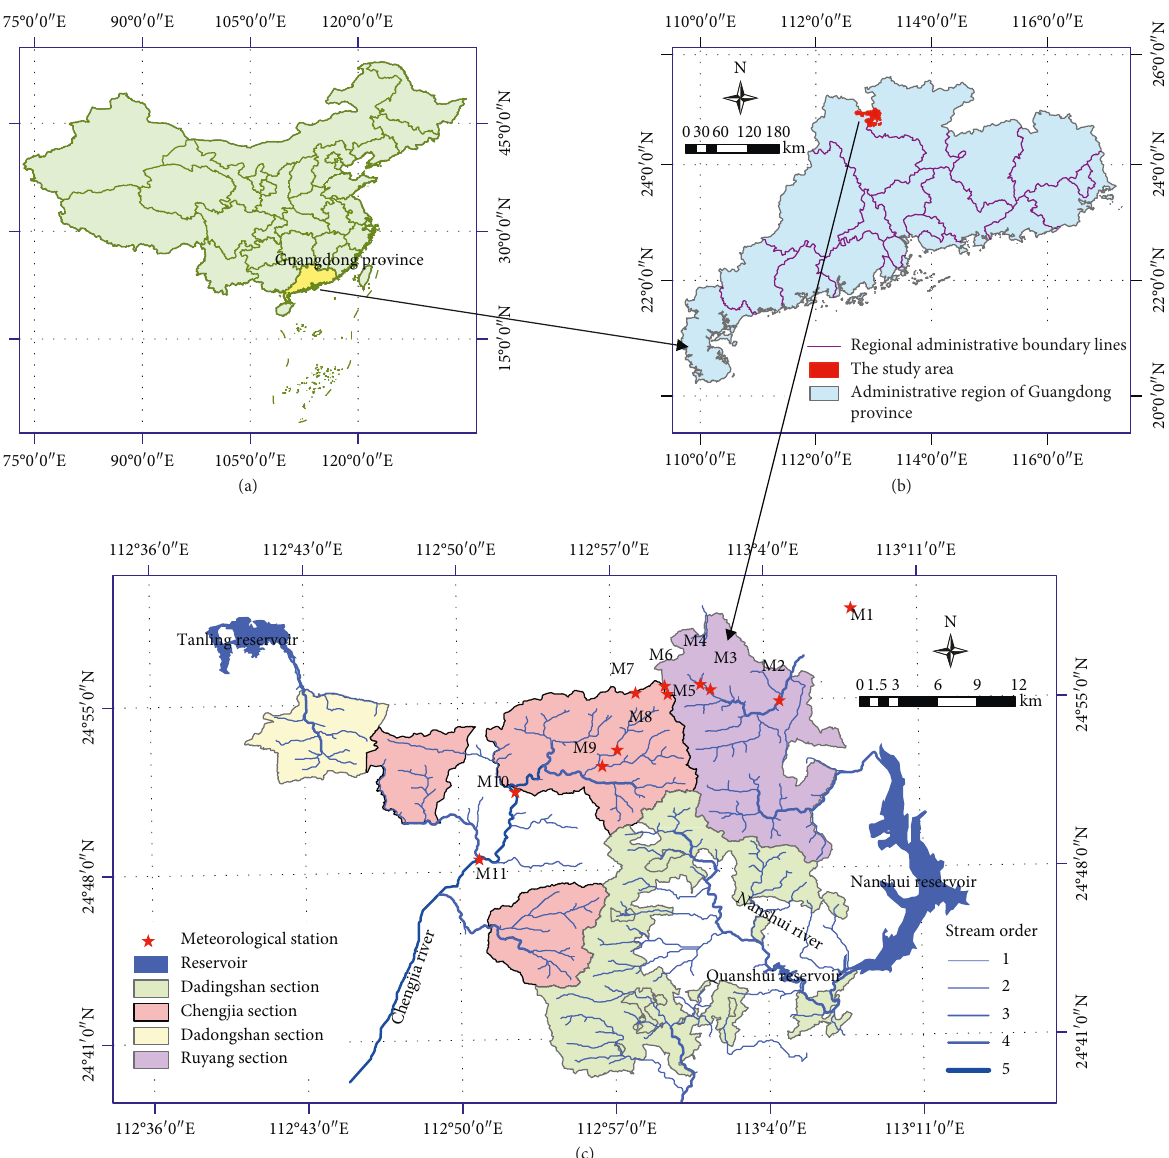
Figure 1: Location of the study area: (a) inset map showing the location of Guangdong Province in China, (b) inset map showing the location of the study area in Guangdong Province, and (c) map of the study area with stream order and four major sections. Figure 1 is reproduced from Wang et al. [28] (under the Creative Commons Attribution License/public domain).